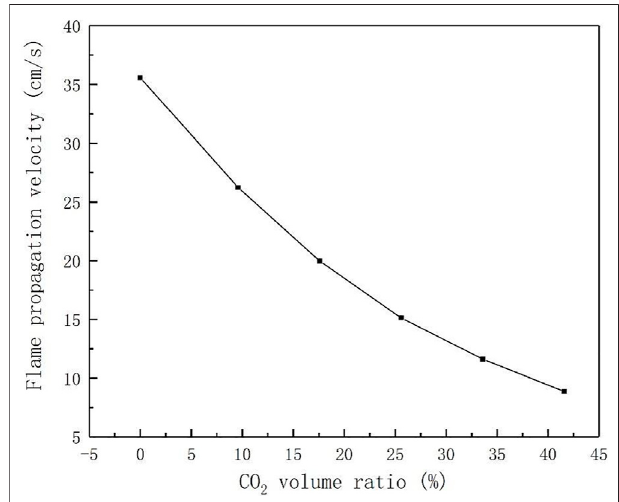
FIGURE 1 | Curve of fl ame temperature with distance under different CO 2 concentrations. FIGURE 2 | Variation curve of